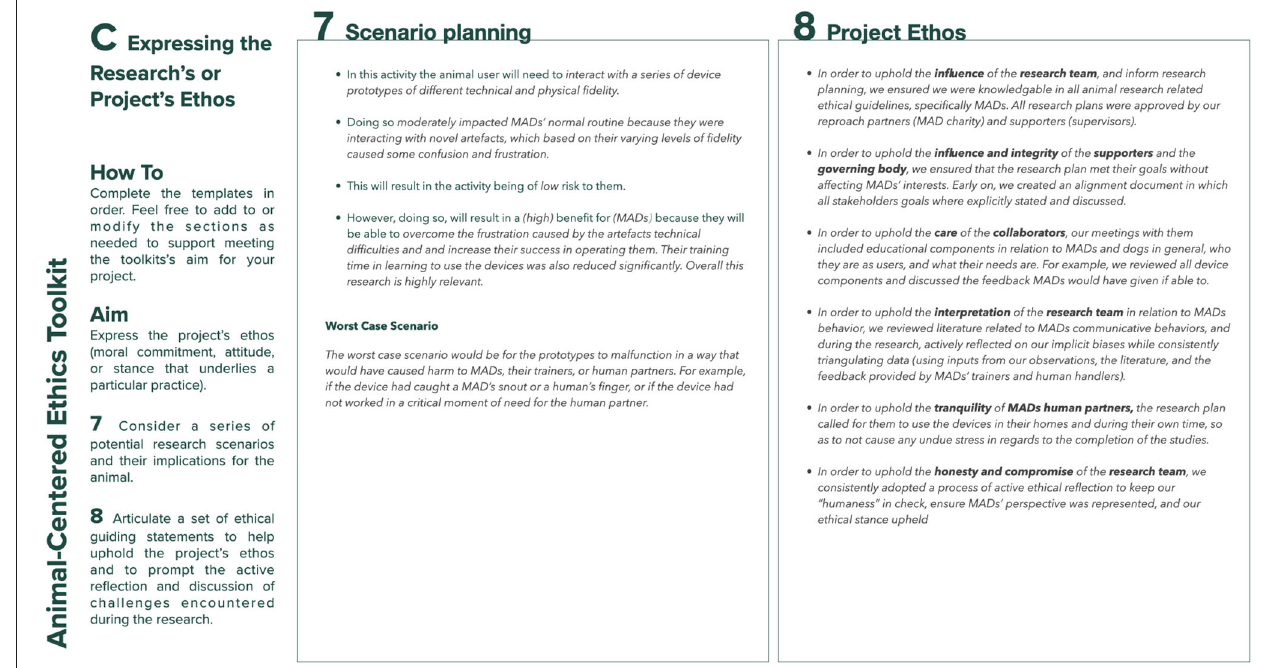
FIGURE 7 | Sample of template C: expressing the project’s ethos for the design of a set of canine-centric controls for Mobility Assistance Dogs.